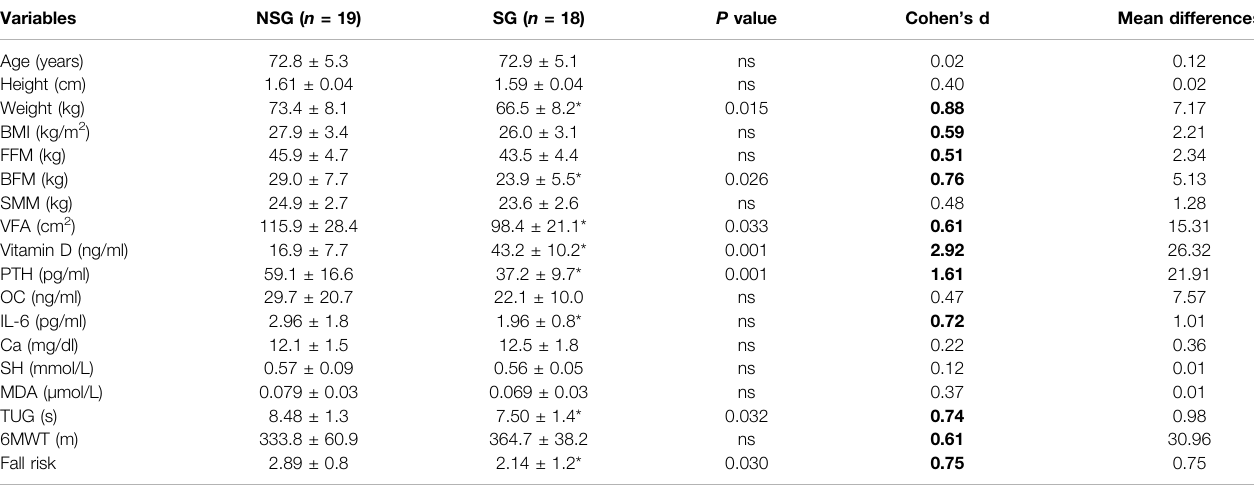
TABLE 1 | Characteristics of the